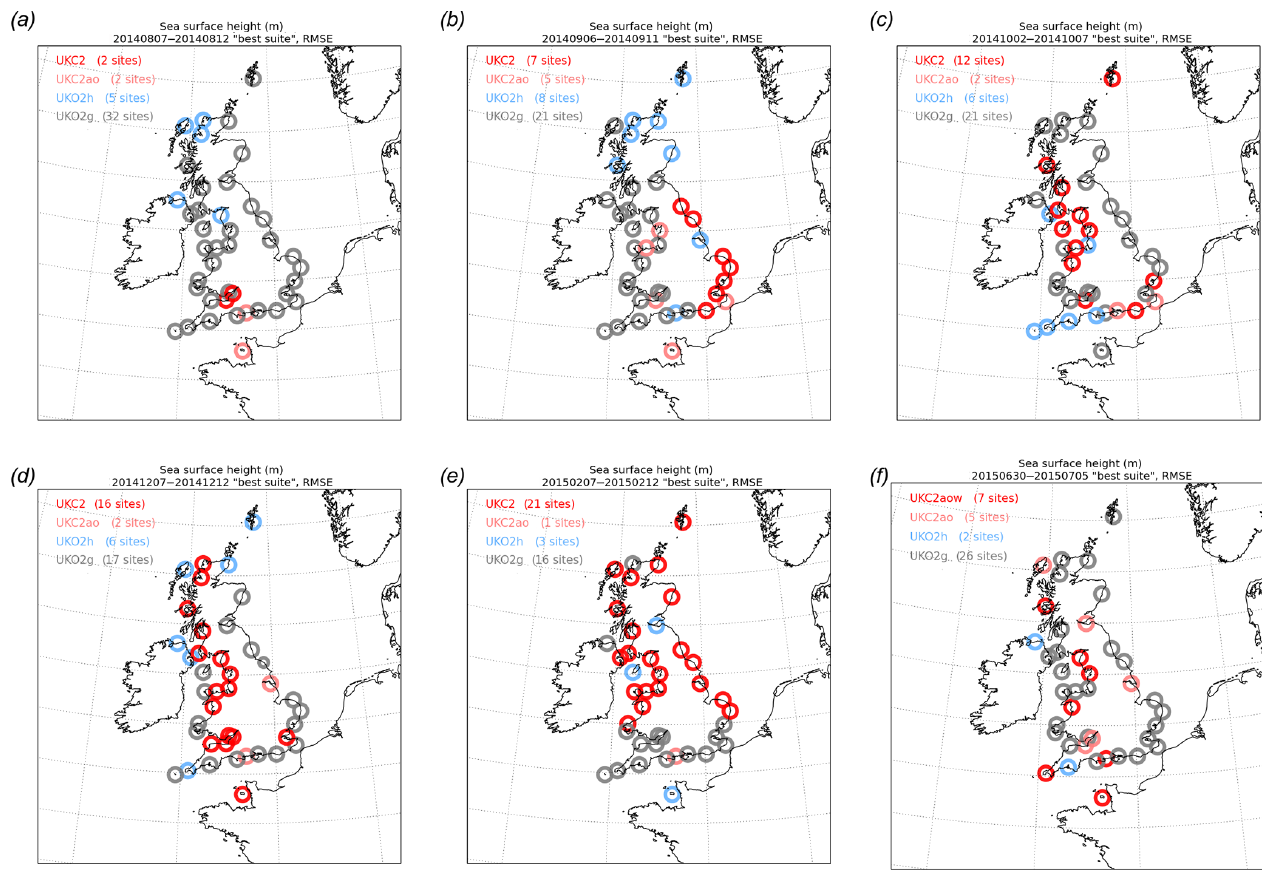
Figure 11. Distribution of in situ observation sites for which each of UKC2aow, UKC2ao, UKO2h or UKO2g ocean model sea surface height outputs provided the lowest RMSE statistic for each 5-day case study. Note that only an inner section of the domain is presented for